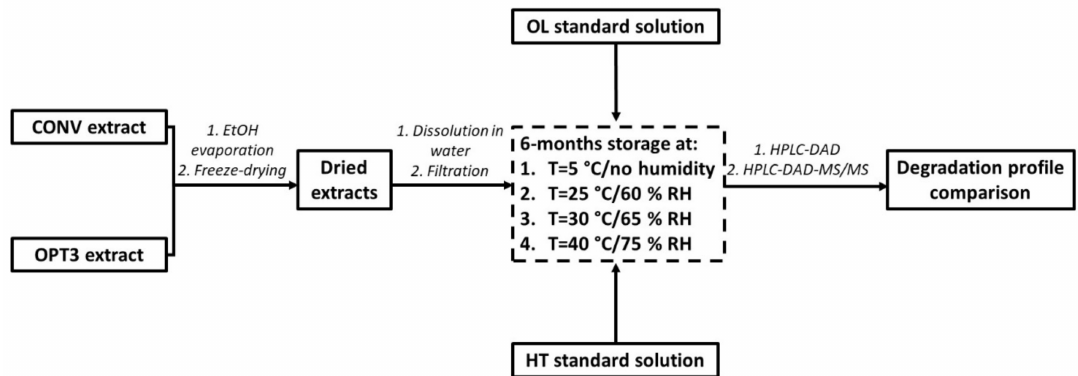
Figure 6. Experimental procedure of the stability studies performed for aqueous solutions of oleuropein (OL) and hydrox- ytyrosol (HT) standards, as well as of conventional (CONV) and optimized (OPT3) extracts at 4 different conditions of temperature (T) and relative humidity